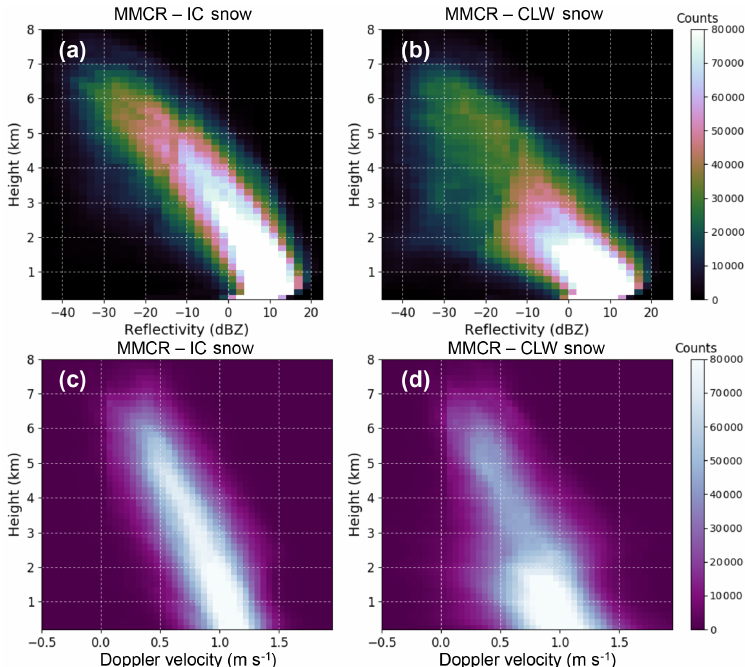
Figure 6. Composite two-dimensional histograms of MMCR properties for each MWR-determined snow type are shown. Each histogram uses a linear color scale with a maximum value of 80000 counts. Panels (a, b) show the MMCR reflectivity as a function of height for all the IC and CLW snow cases, respectively. Panels (c, d) show the MMCR Doppler velocities as a function of height. These composites of the IC and CLW precipitation highlight different characteristics between the two snow